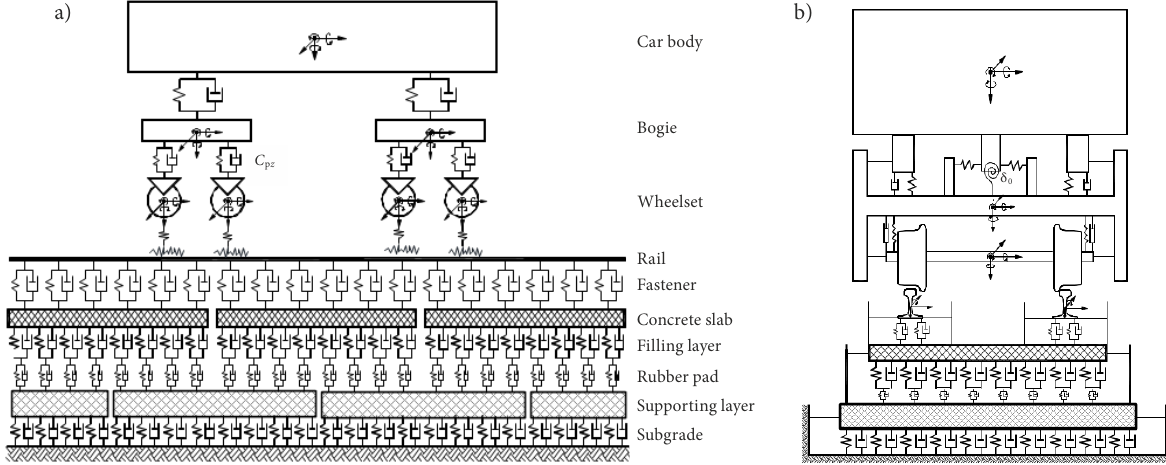
Figure 1. 3D coupled dynamic model of a vehicle and the low vibration slab track: a – elevation view; b – end